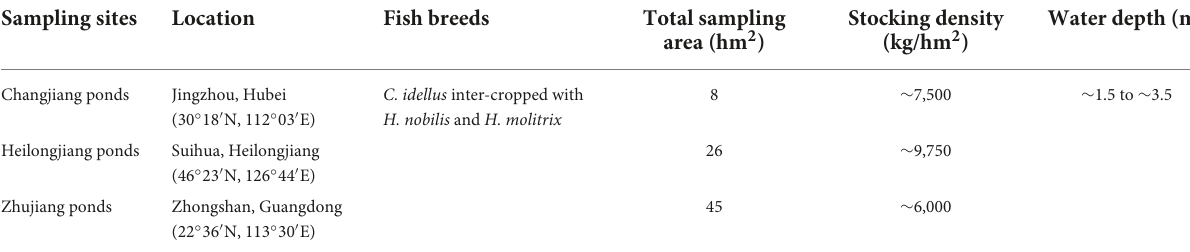
TABLE 1 General information about the sampling